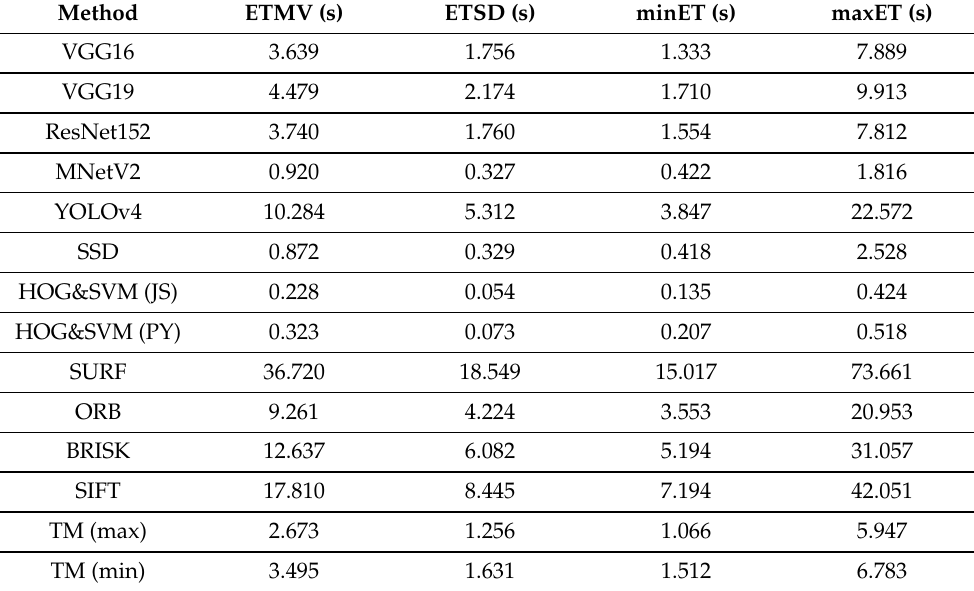
Table 6. Temporal results of the tests performed on the tactode_small test dataset.